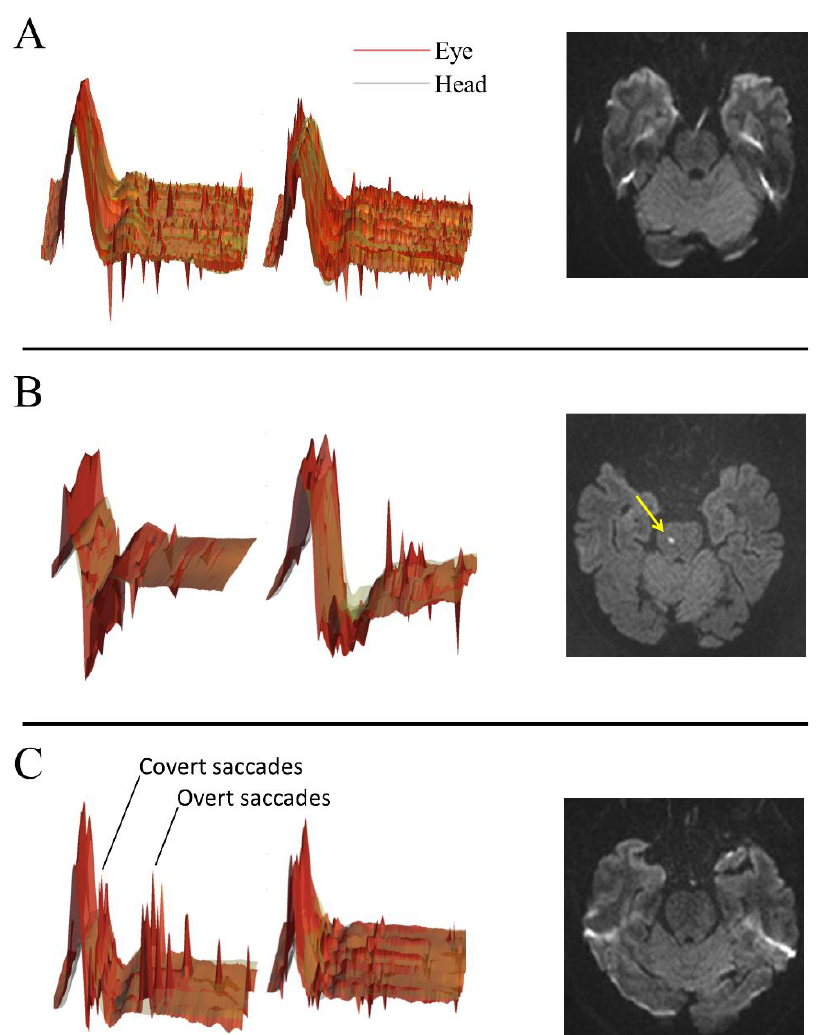
Figure 2. Video-oculography and cranial MRI correlates. ( A ) Conventional and V-HIT-assisted HINTS plus with an abnormal pattern, but normal caloric testing and brainstem and cerebellar MRI without pathological findings (diffusion trace map). ( B ) Abnormal pattern on conventional and V-HIT-assisted HINTS plus suggestive of a central lesion. Right paramedian punctuate diffusion restriction of an acute pontine infarction (yellow arrow). ( C ) Benign pattern on both HINTS plus examinations suggestive of peripheral vestibulopathy, unremarkable diffusion MRI, caloric testing confirmed unilateral vestibulopathy on the right side.